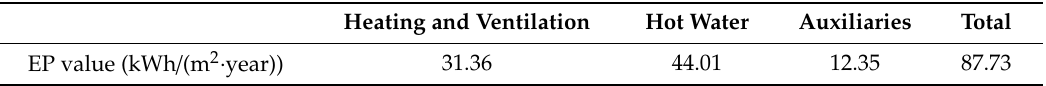
Table 10. The annual primary energy demand (kWh / (m 2 · year)) for the multi-family building at Akacjowa Street in Goleniow (gas boiler room).